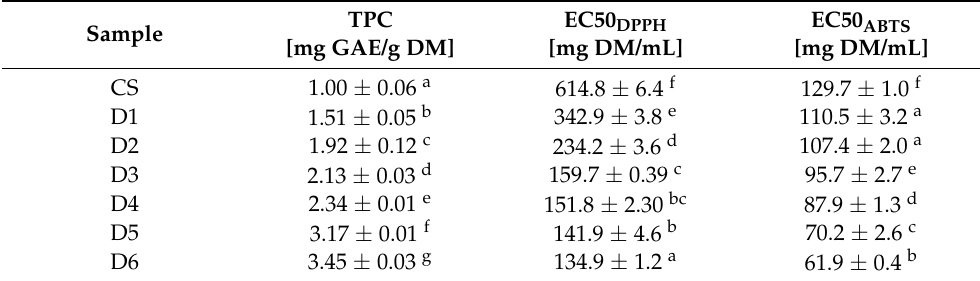
Figure 2. Color coordinates and total color difference ( ∆ E) of bread samples. CS, D1, D2, D3, D4, D5, D6—control bread and bread with 1, 2, 3, 4, 5 and 6% of DF, respectively. Data are presented as means with standard deviations ( n = 6). Values of each parameter with different letters (a–f) are significantly different ( p < 0.05). Table 5. Total phenolic content and antioxidant activity of control and enriched